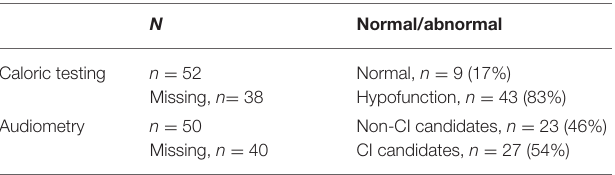
TABLE 1 | Overview of audiometry and caloric testing results with the missing data in all 90 ears. N